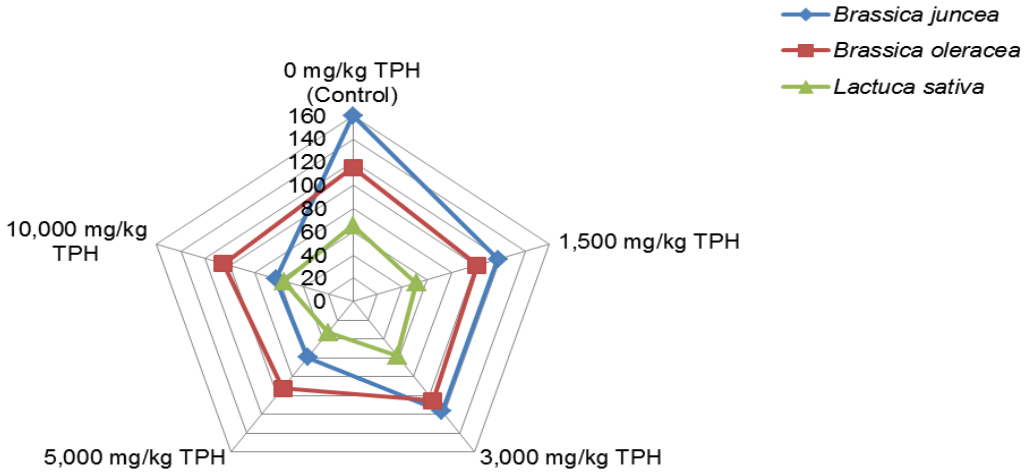
Figure 2. E ff ect of crude oil contamination on stomatal conductance (mmol / m 2 s) of selected green leafy Figure 2. Effect of crude oil contamination on stomatal conductance (mmol/m 2 s) of selected green vegetables prior to harvest. Source: Odukoya leafy vegetables prior to harvest. Source: Odukoya [5].